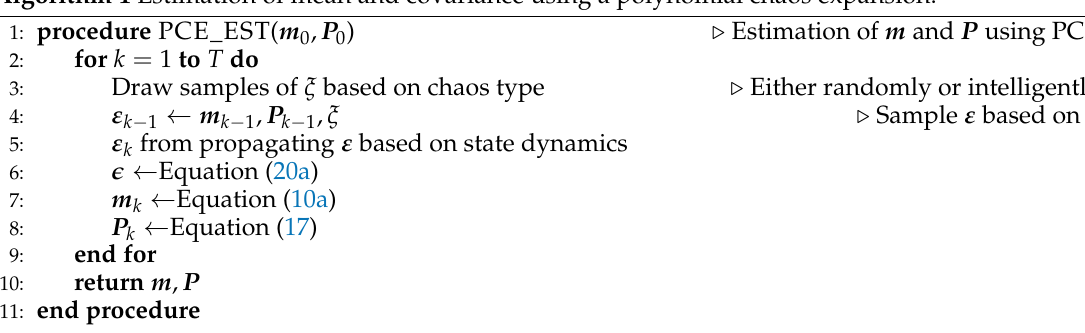
Algorithm 1 Estimation of mean and covariance using a polynomial chaos